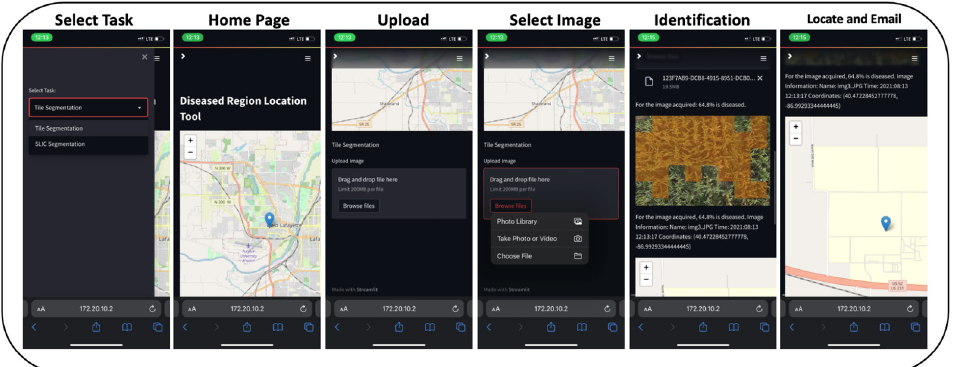
Figure 15. GeoDLS smartphone application.